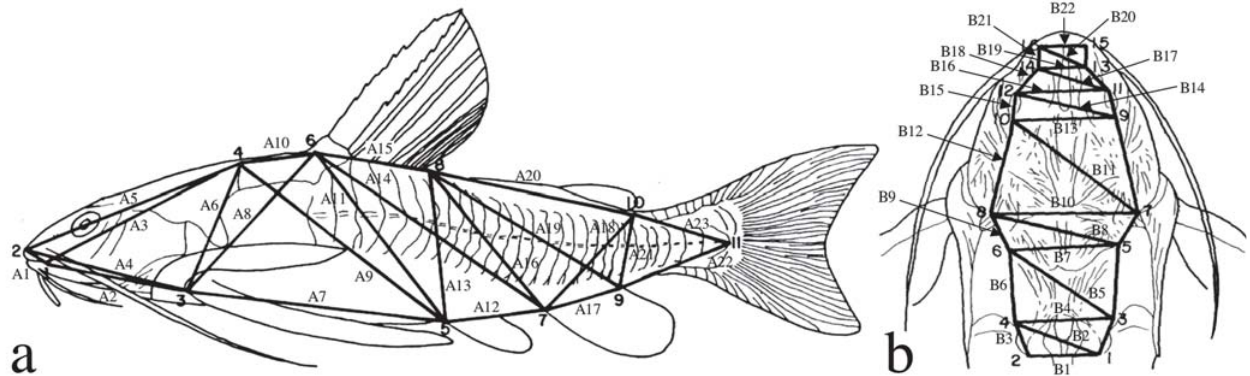
Fig. 1. Sets of anatomical landmarks (numbered) and distance measurements among them for trussnets of lateral head and body (A) and dorsal head and nuchal shield (B).